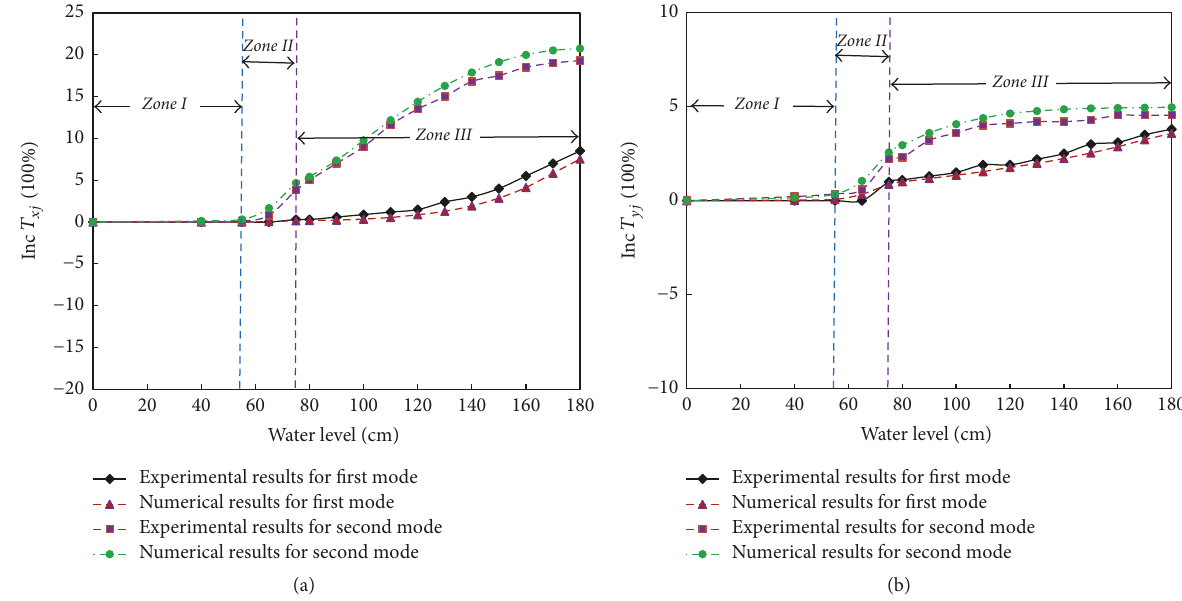
Figure 13: Measured and computed period percentage increases for the pier specimen with a 12.1kg tip mass as a function of water level: (a) the first two lateral modes along 𝑥 -axis; (b) the first two lateral modes along 𝑦